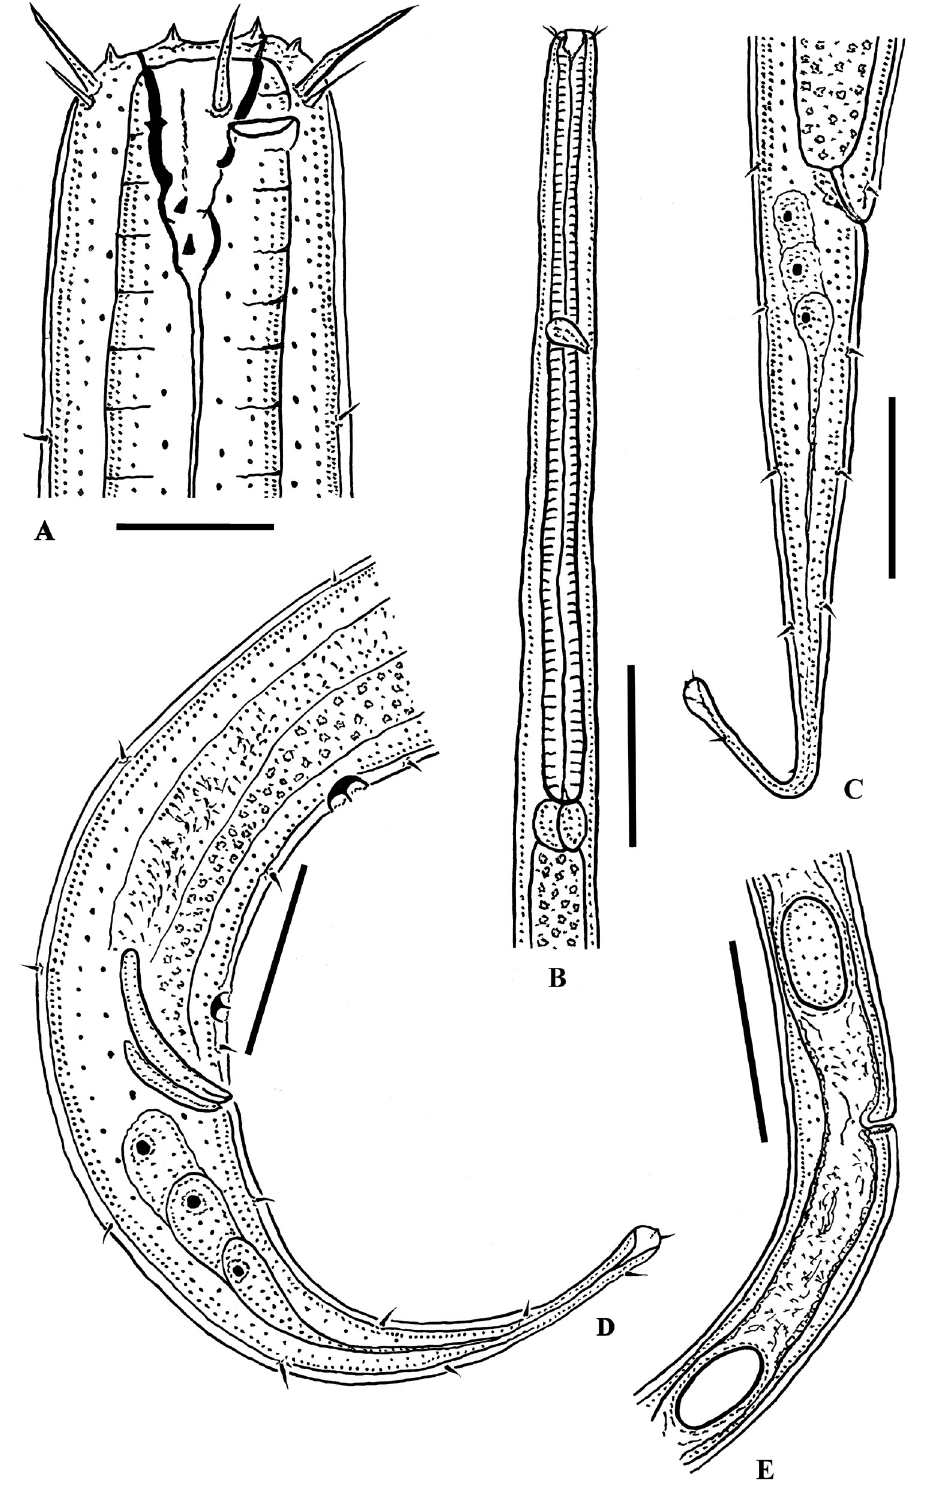
Fig. 1. Tobrilus elginus sp. nov. A . Male anterior end. B . Male pharyngeal region. C . Female posterior body end. D . Male posterior body end. E . Female vulva region. Scale bars: A = 20 µm; B, E = 100 µm; C–D = 50